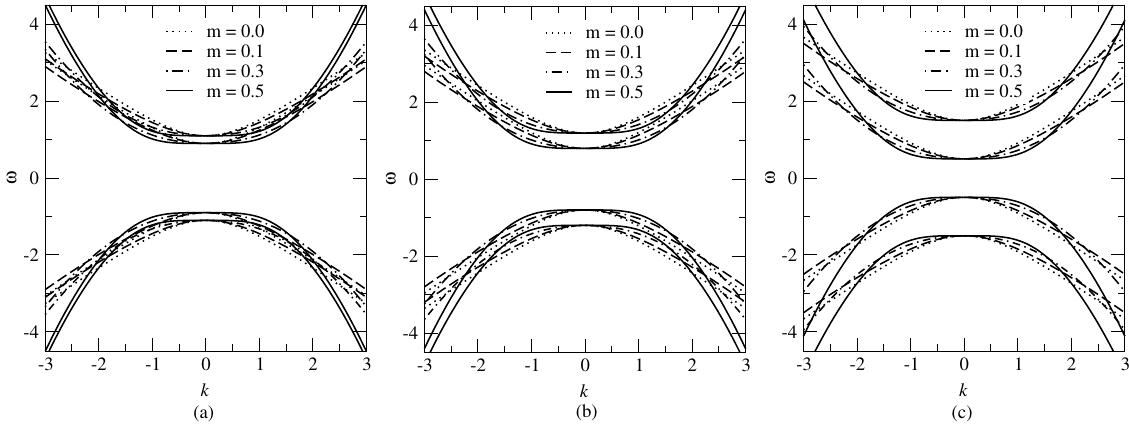
Figure 1. Dispersion diagrams for m = 0, 0.1, 0.3 and 0.5. ( a ) λ = 0.1, ( b ) λ = 0.2, and ( c ) λ =